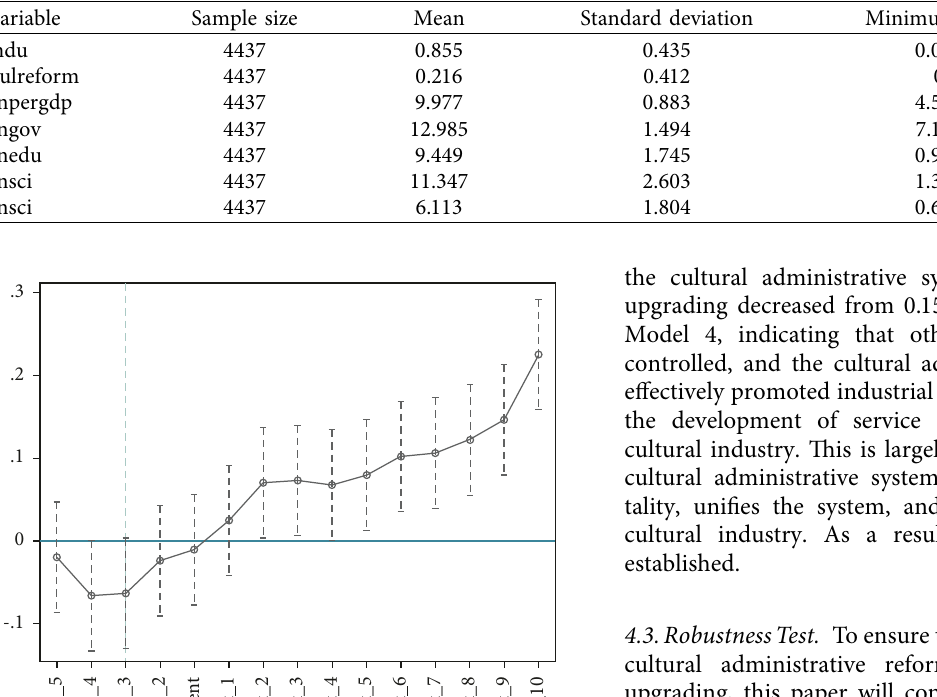
Table 2: Descriptive statistics of table variables.